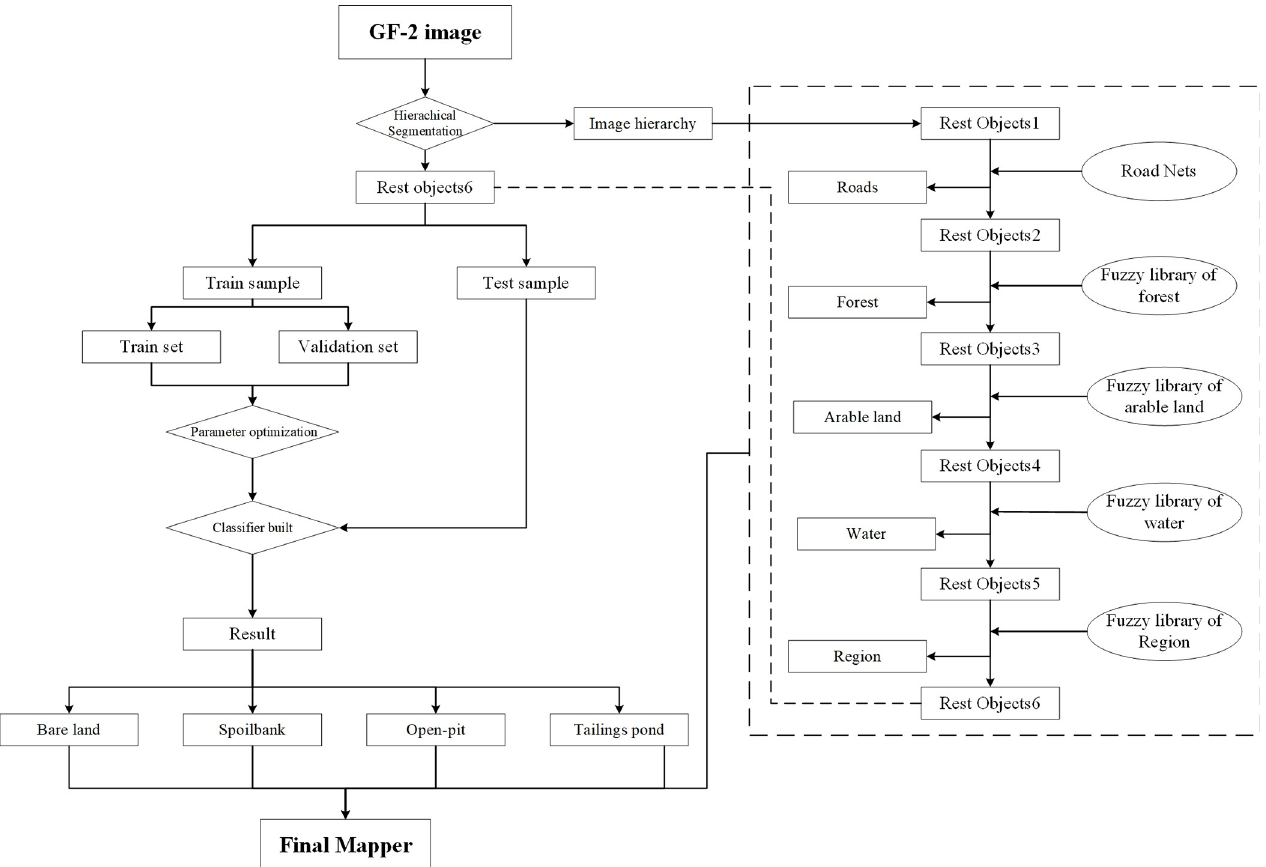
Fig 2. Method flow chart of this